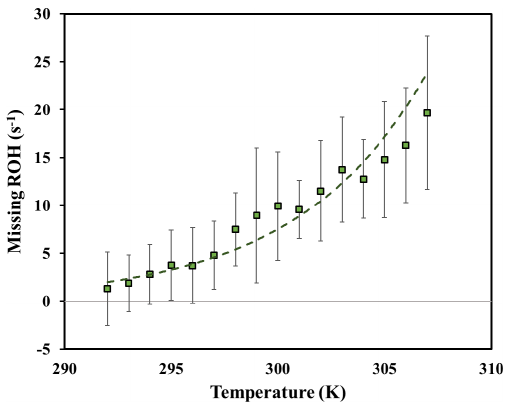
Figure 9. Daytime missing OH reactivity binned by ambient tem- perature for the 6m height for temperatures ranging from 292 to 308K. Error bars represent the standard deviation on missing OH reactivity calculated for each temperature